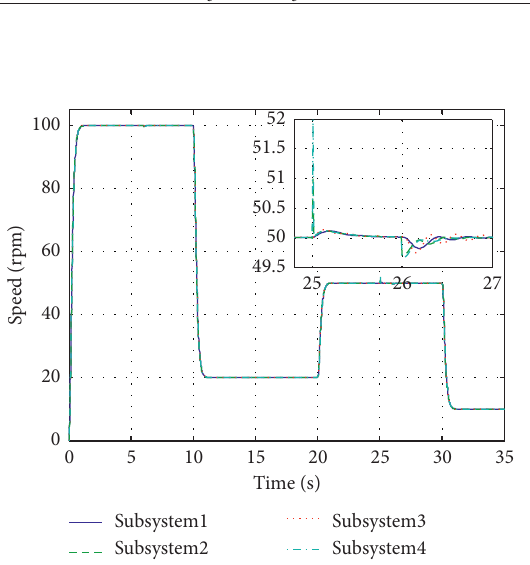
Figure 10: Synchronous output of